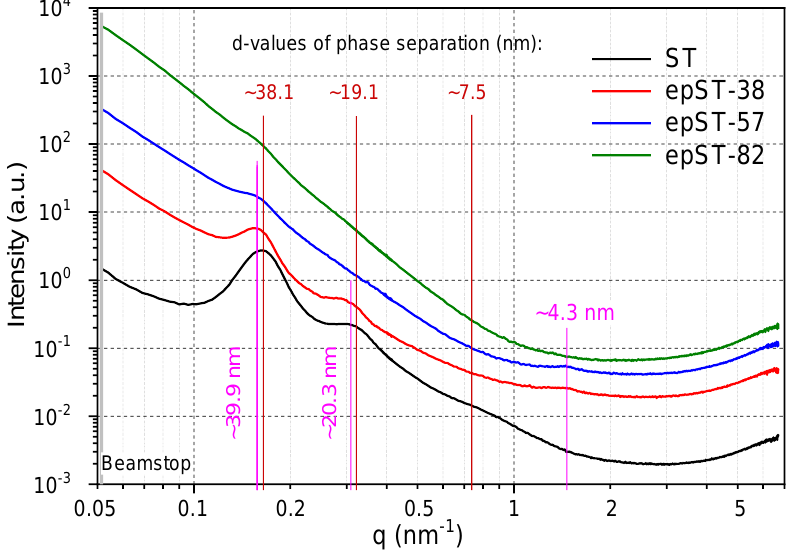
Figure 7. Small-angle X-ray scattering (SAXS) intensity profiles for virgin ST and its epoxidized grades at room temperature.